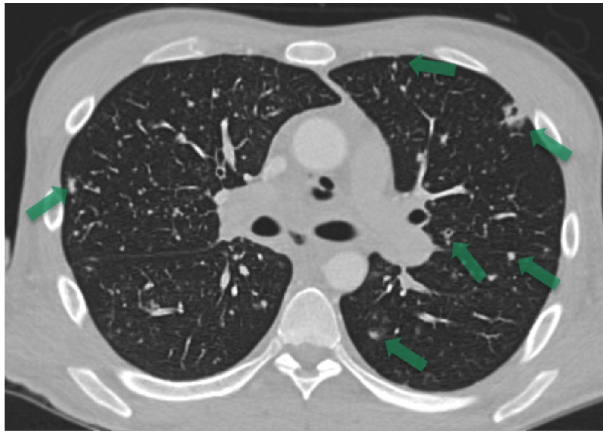
Figure 3. Chest CT on admission revealed multiple cavitary and non-cavitary lung nodules (arrows), suspicious for mycobacterial